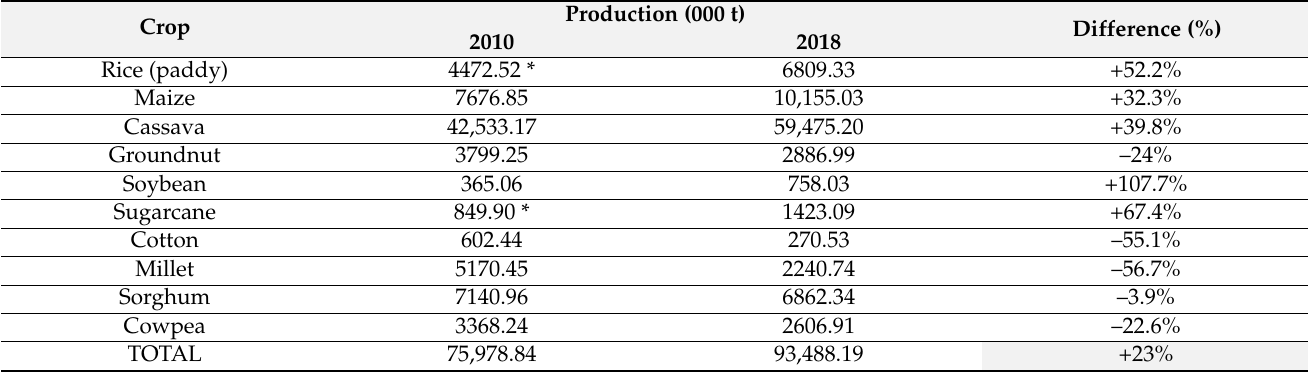
Table 7. Crop production, 2010 vs. 2018. Data taken from